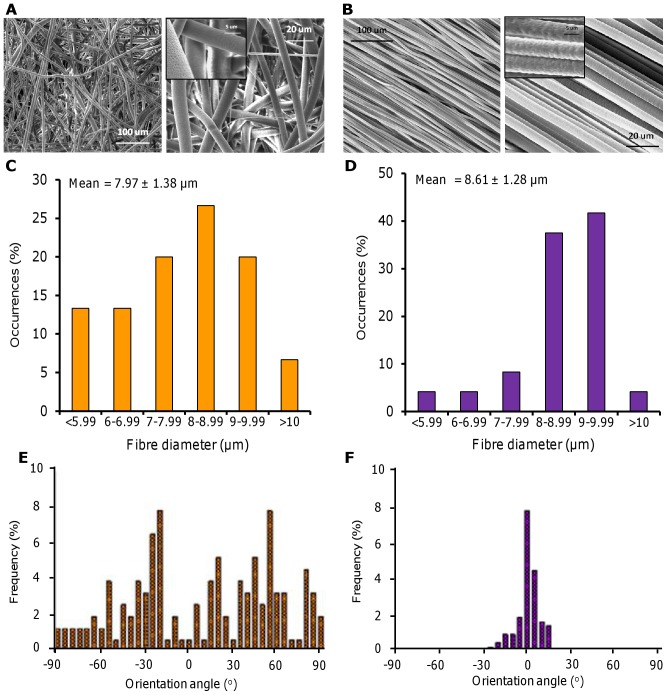
Electrospun PCL fibres with a random orientation or highly aligned.Random (A) and aligned (B) fibres were formed from a PCL (80 kDa) 15 w% in DCM solution. Conditions were 4 ml/h, 11 kV, 20 cm Wd, 200 rpm (A) and 2000 rpm (B). SEM micrographs (A–B) show different magnifications (insert scale bar is 5 µm). Fibre diameter distribution (C–D) and frequency of fibre orientation (E–F) were calculated from 150 fibres (n = 3).